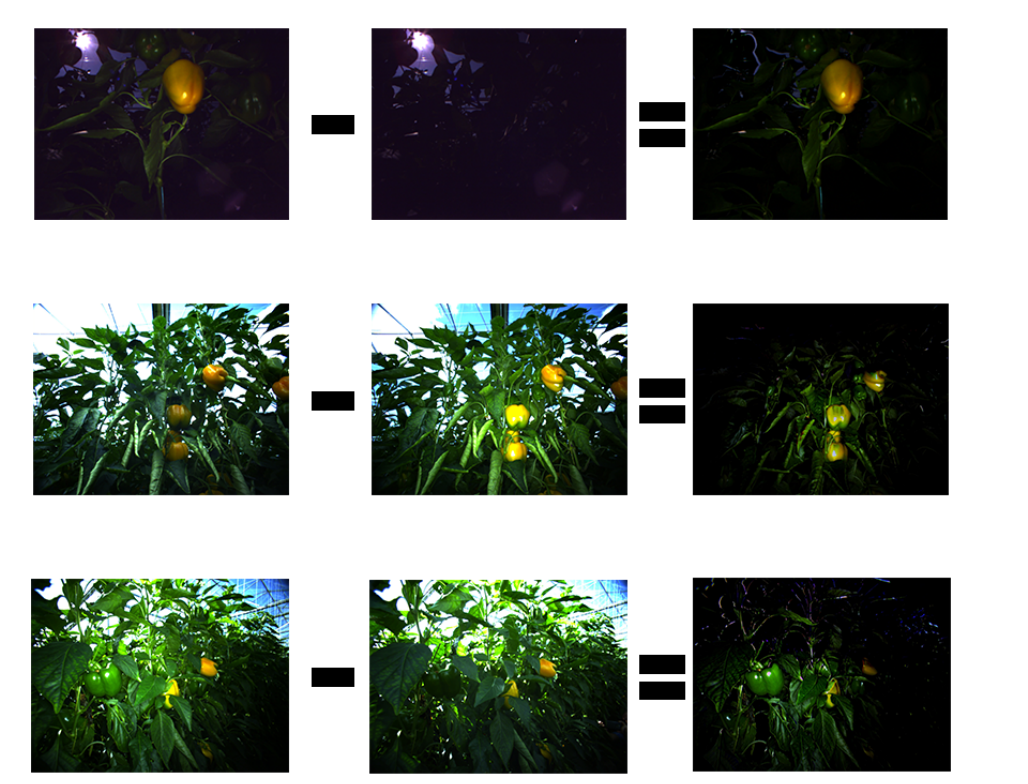
Figure 2. Examples of the Flash-no-Flash process images taken facing the sun ( top row ), facing away from the sun ( center row ), and facing to the side ( bottom row ). By subtracting the luminance values of the No-Flash image ( center column ) from the Flash-only image ( left column ), natural scene illumination is removed ( right column